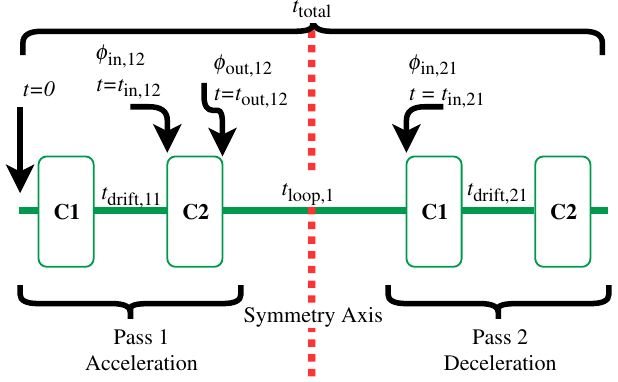
FIG. 2. Cavity encounter sequence for a 2-pass ERL with N ¼ 2 physical cavities, denoted C1 and C2, and cavity phase inputs ϕ and outputs ϕ associated with corresponding in ;mn out ;mn input/output times t . The total time spent in the ERL, t , is total represented by the length of the horizontal line. This schematic can be extended to general multipass ERLs by inserting addi- tional cavities or return loops on both sides of the dotted symmetry